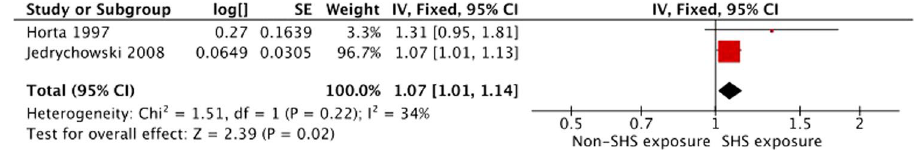
Figure 4. Impact of discontinuation of breastfeeding at 6